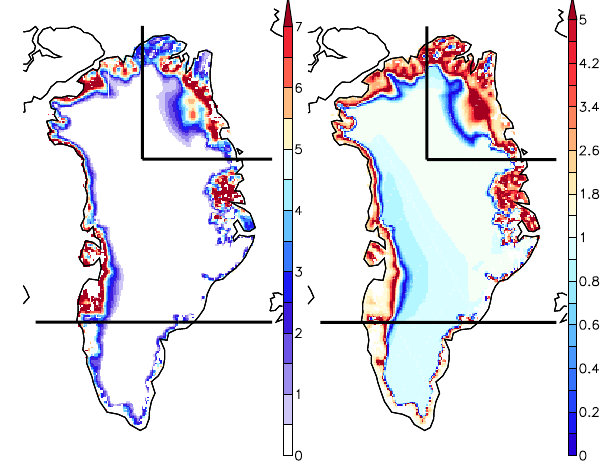
Left: Ratio between melt anomaly and preindustrial accumulation, ( ABL 126 ka − Fig. 8. (Left) Ratio between melt anomaly and preindustrial ABL 0 ka )/ ACC 0 ka . It quantifies surplus melting in ‘accumulation-years’, a measure of instability. The accumulation, (ABL 126 ka − ABL 0 ka )/ACC 0 ka . It quantifies northeastern region of Greenland is the least stable. Right: Ratio of absolute surface mass balances, surplus melting in “accumulation-years”, a measure of in- − ABL ) 126 ka / ( ACC − ABL ) 0 ka . For mass flow to balance surface imbalances, it needs to in- ( ACC stability. The northeastern region of Greenland is the least crease by the same factor, which is unrealistically large for the northeastern GrIS. stable. (Right) Ratio of absolute surface mass balances, (ACC − ABL) 126 ka /(ACC − ABL) 0 ka . For mass flow to bal- ance surface imbalances, it needs to increase by the same factor, which is unrealistically large for the northeastern 17